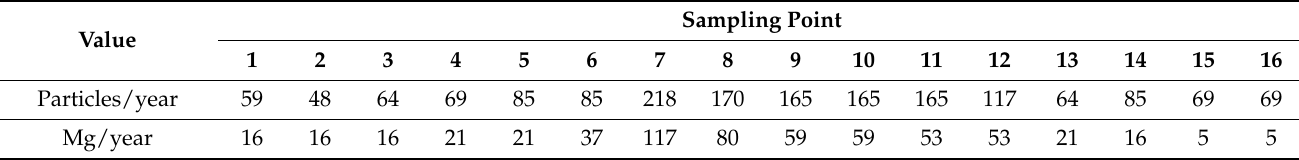
Table 1. Estimated number of particles accumulated per year (Values are normalized to